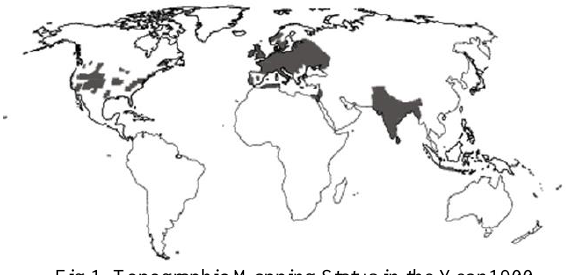
Fig.1 Topographic Mapping Status in the Year